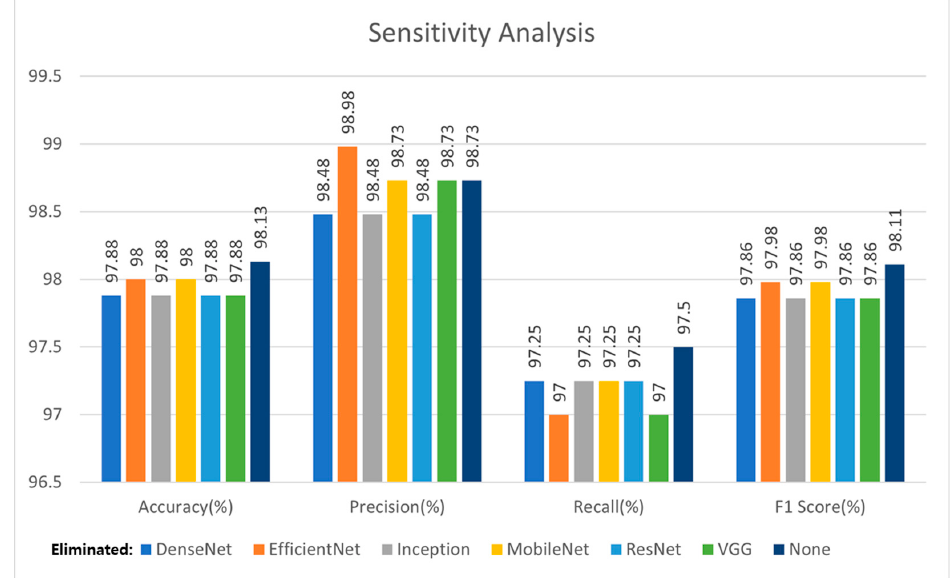
Figure 15. Sensitivity analysis results by eliminating one of the models.